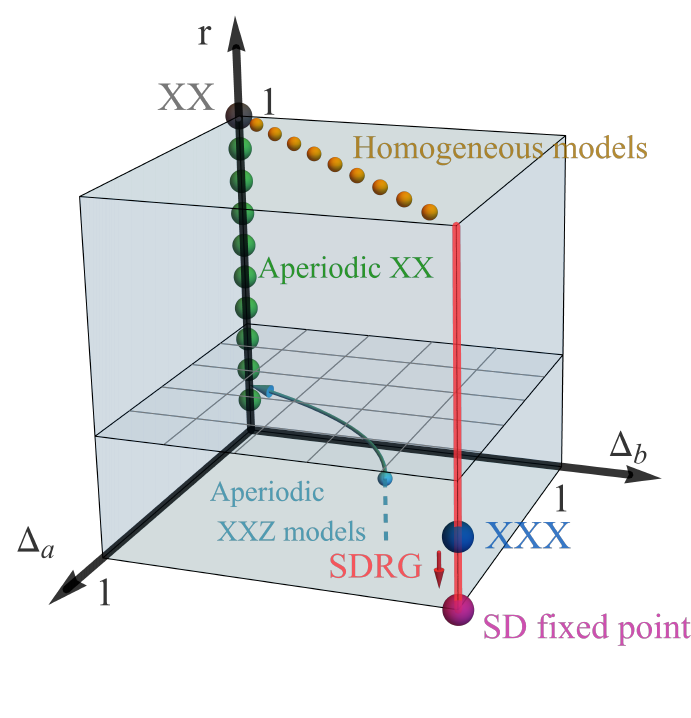
Figure 6: Phase diagram of the aperiodic XXZ chain in the critical regime. The SDRG approach is reliable in the bottom part of the parameter space only (indicated schematically by the grid plane), while the exact methods in [ 52 ] allow to establish the marginality of the modulations in aperiodic XX chains for any 0 (cid:182) r < 1. The resulting fixed points are r -dependent and are shown in green. The axes ∆ ∆ are necessary because of the effective aperiodicity induced by the SDRG on the b anisotropy ∆ , which is not modulated in the original chain (see 0